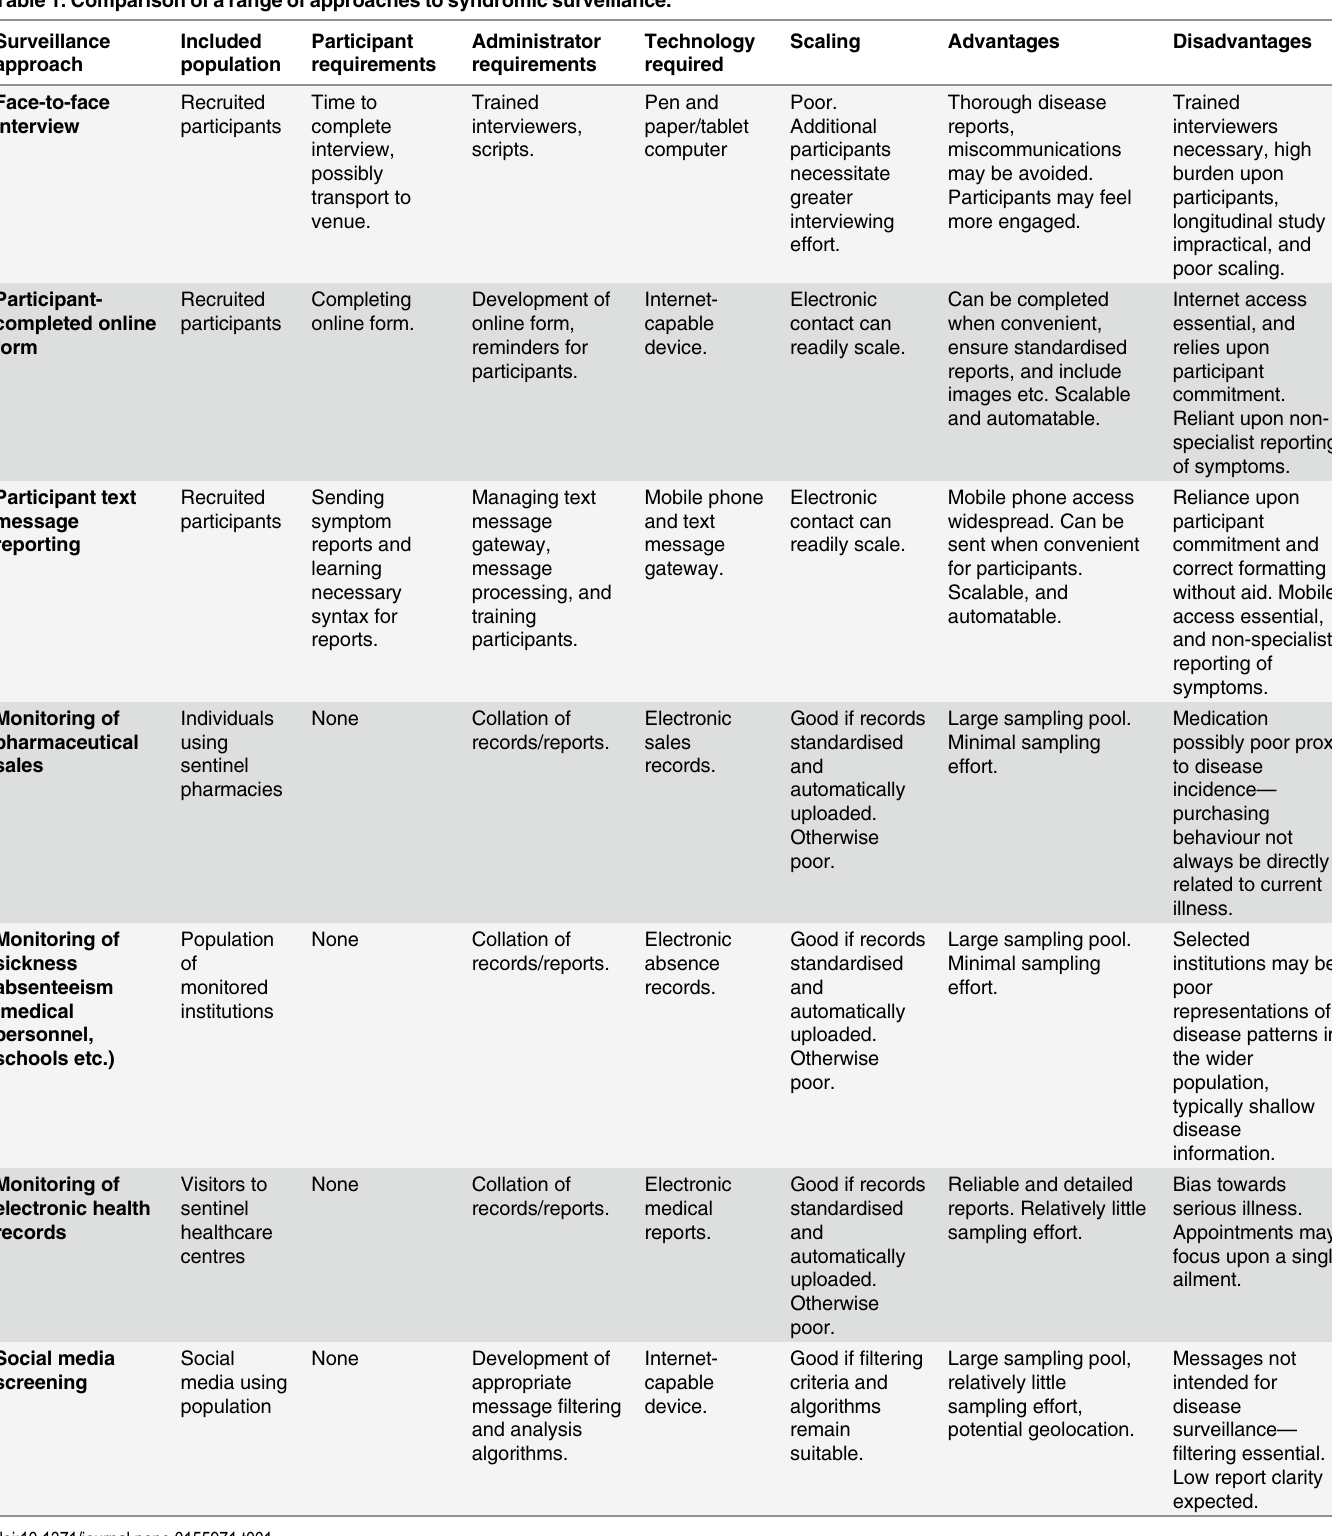
Table 1. Comparison of a range of approaches to syndromic